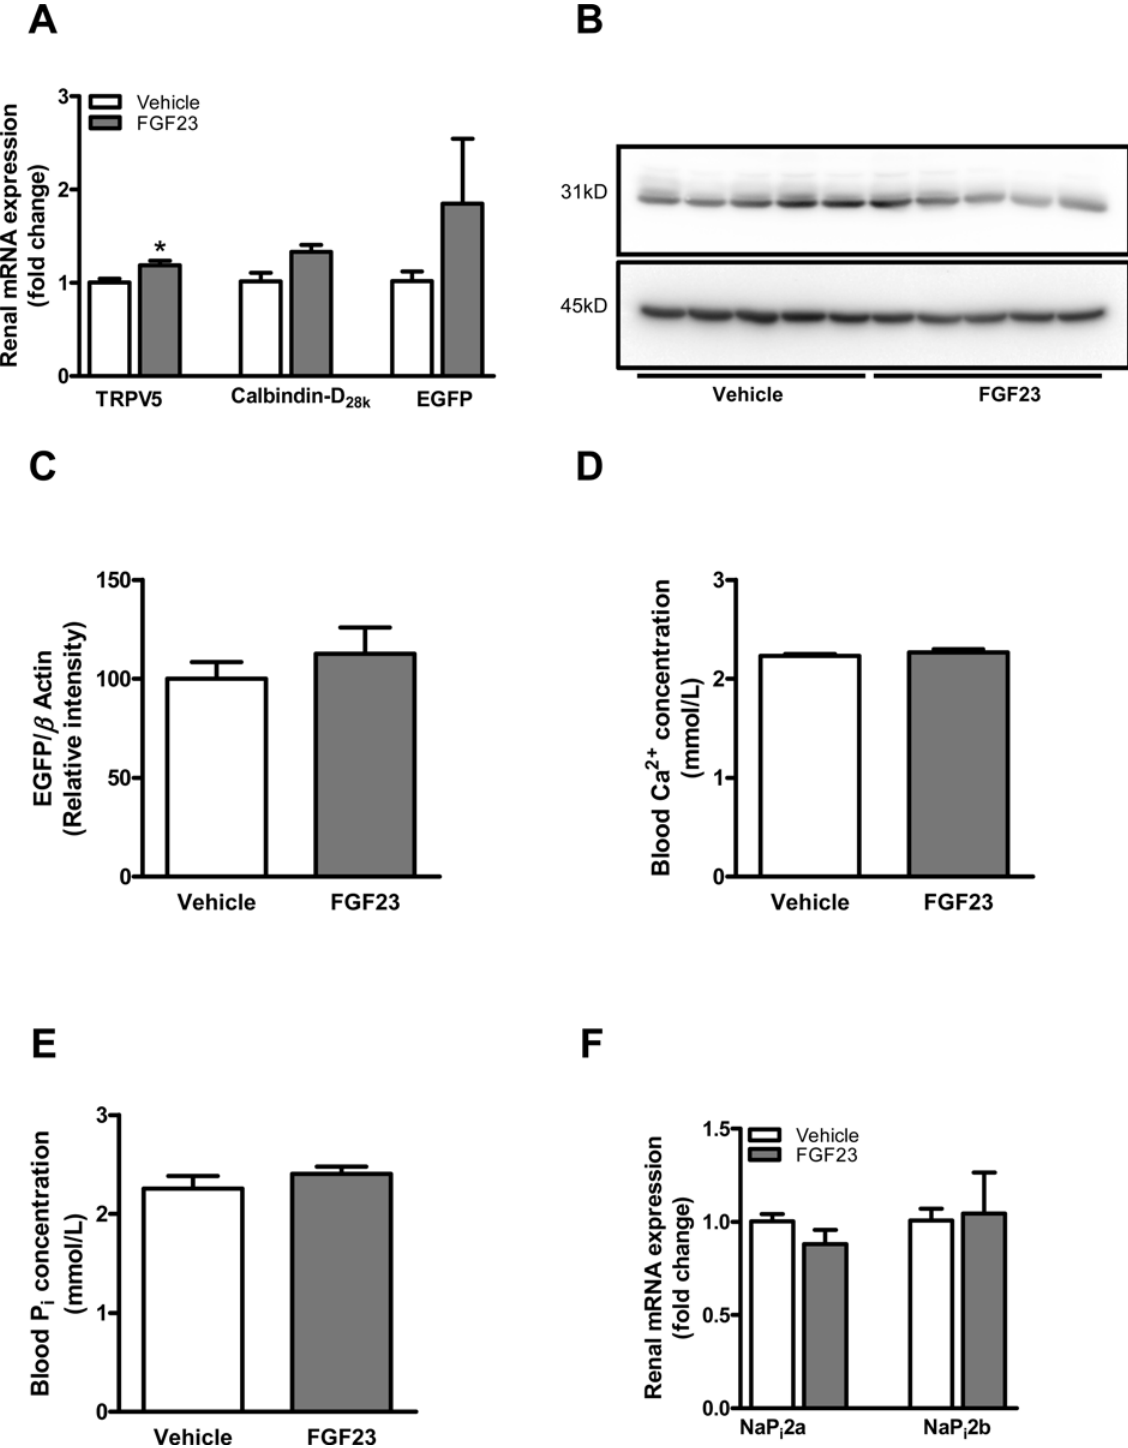
Fig 6. FGF23 administration directly affected renal tubular calcium transport. (A) Intravenous administration of recombinant FGF23 protein (dark-gray bars) results in increased TRPV5 and a tendency towards elevated calbindin-D 28k renal mRNA expression, when compared to vehicle-treated mice (white bars). Renal EGFP mRNA expression, as a surrogate marker for TRPV5 transcription tended to be increased following FGF23 administration compared to vehicle-treated mice. (B) Representative immunoblot and (C) semi-quantitative analysis of EGFP (B ; upper panel) and β -actin (B ; lower panel) protein expression in renal lysates of vehicle-treated or FGF23 injected mice. Blood (D) Ca 2+ and (E) phosphate levels were measured following 24 hrs of